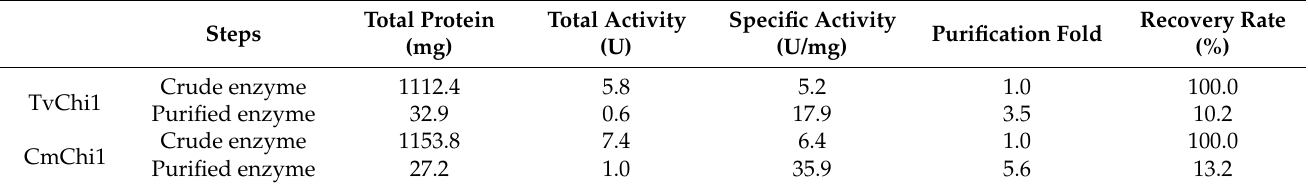
Table 1. Purification of TvChi1 and CmChi1.